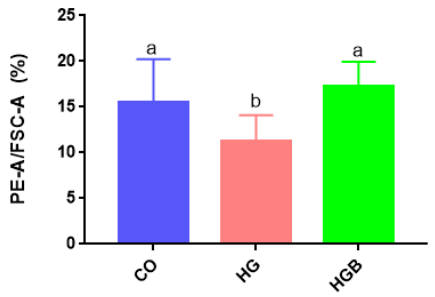
Figure 6. The changes of mitochondria membrane potentials in Landes goose primary hepatocytes in different treatment groups. After 24 h starved in serum-free medium, Landes goose primary hepatocytes were cultured for 48 h with high glucose or high glucose and betaine treatment. Different lowercase letters indicate a significant difference ( p < 0.05). CO: control group (0 mmol/L of glucose + 0 mmol/L of betaine); HG: 20 mmol/L of glucose + 0 mmol/L of betaine group; HGB: 20 mmol/L of glucose + 20 mmol/L of betaine combined treatment